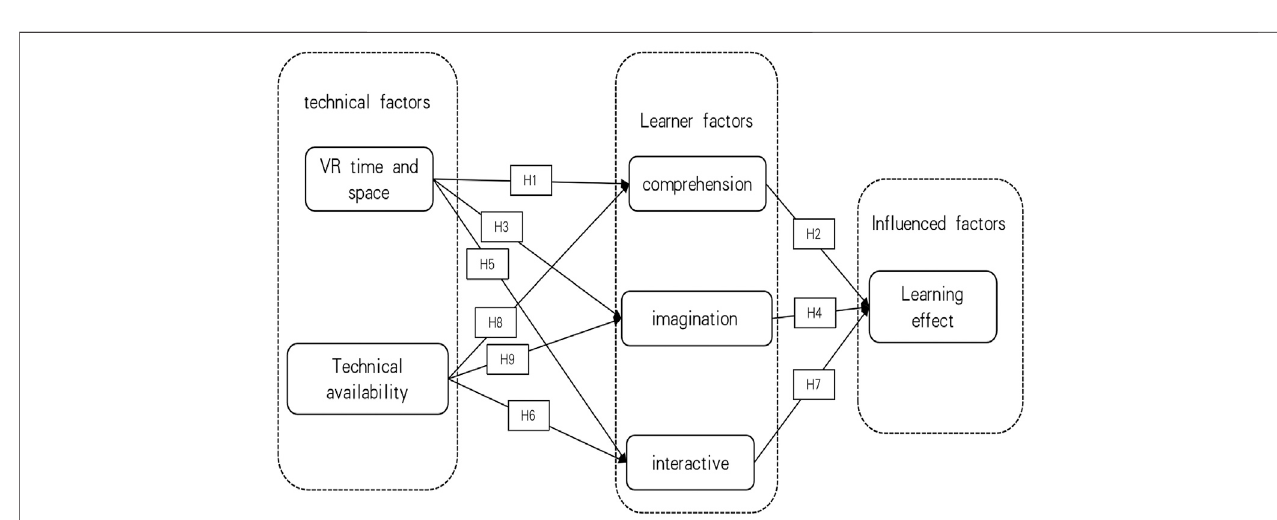
FIGURE 3 | “ You, Calligrapher ” VR